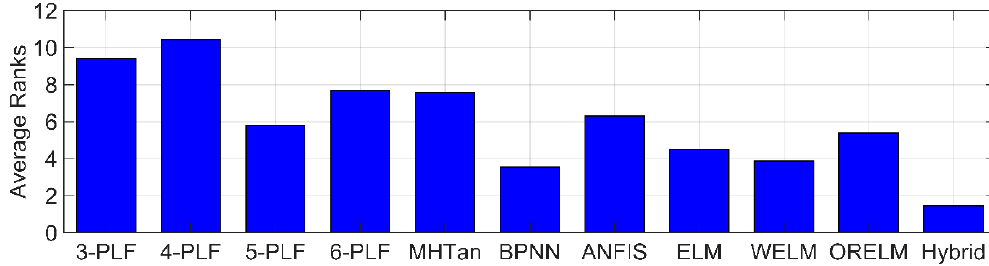
Figure 5. Averages ranks of different models based on all datasets and all error indicators.